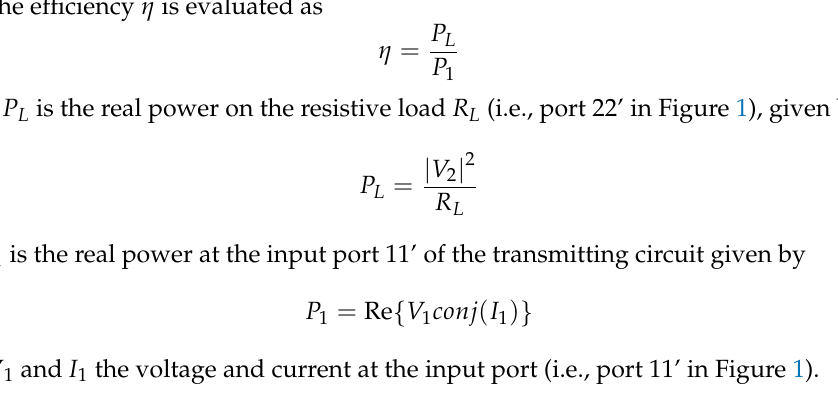
Figure 1. Simplified equivalent circuit of a WPT system with SP compensation. The efficiency η is evaluated